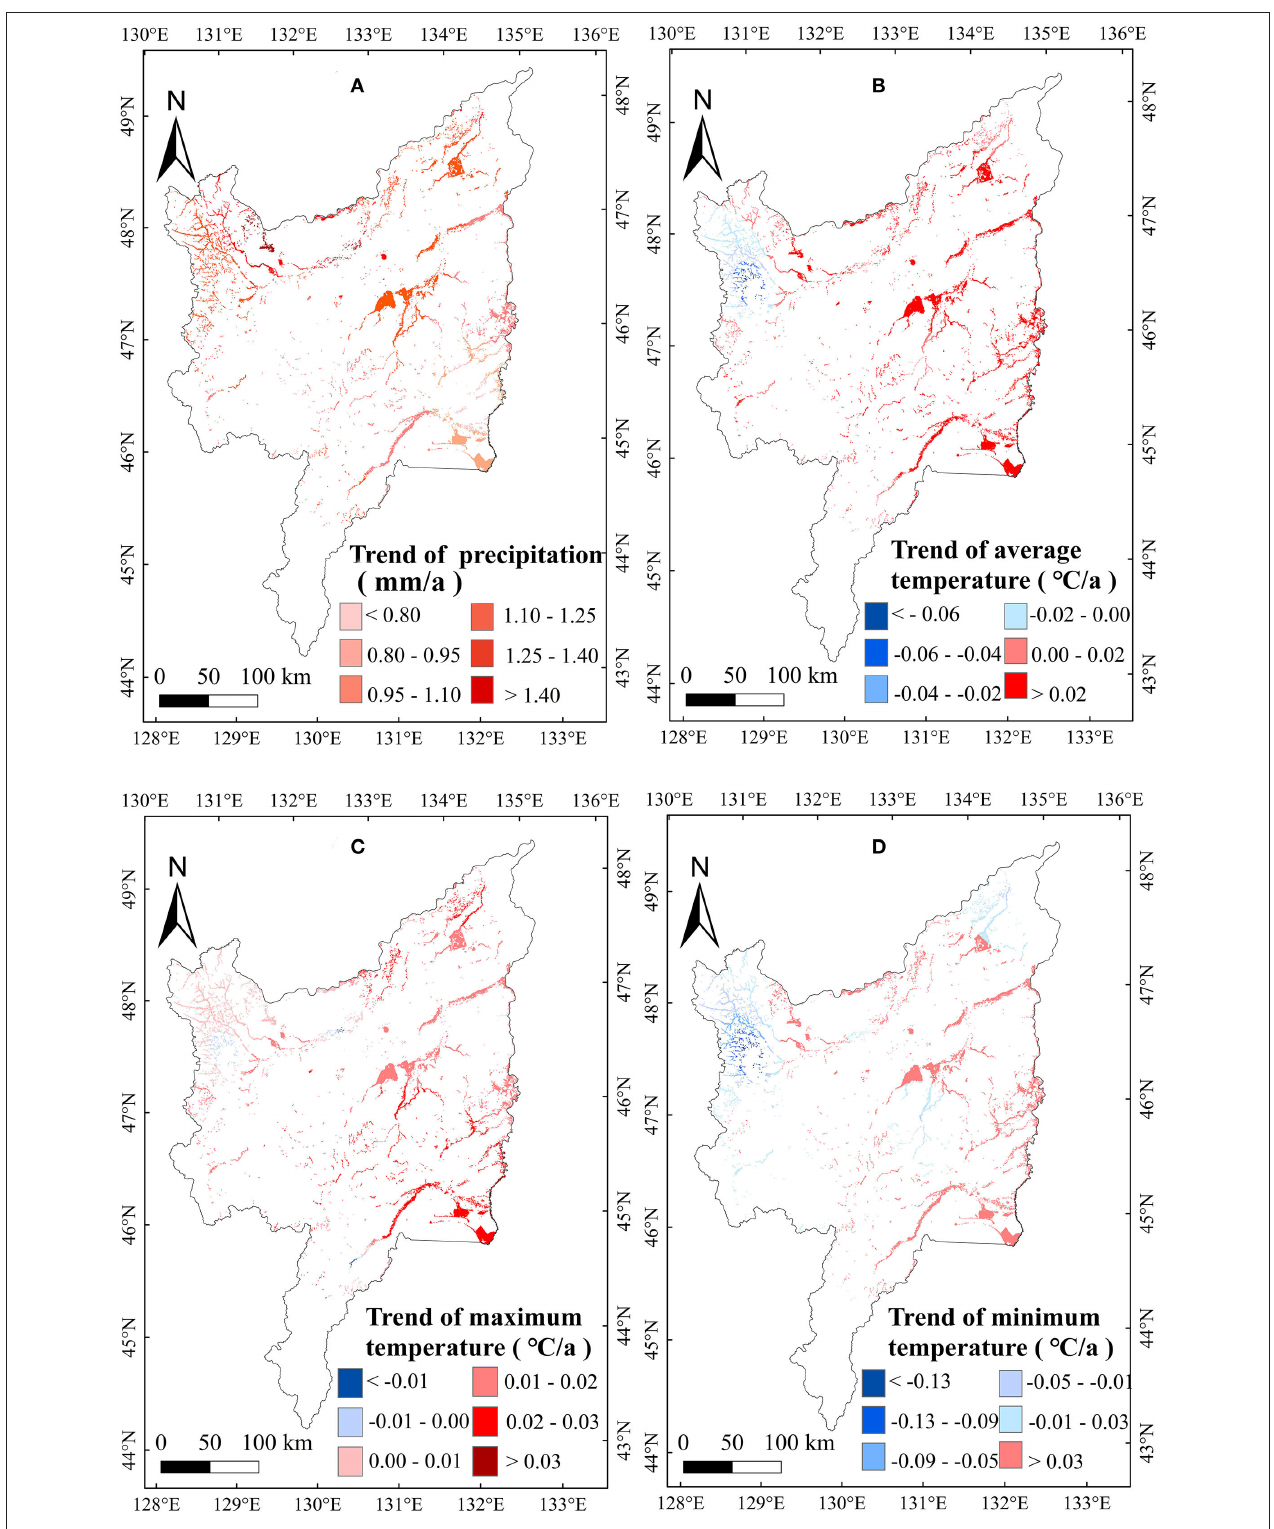
FIGURE 9 | Change trends in annual precipitation (mm/a) (A) , T mean ( ◦ C/a) (B) , T max ( ◦ C/a) (C) , and T min ( ◦ C/a) (D) in marshes of the Sanjiang Plain from 2000 to 2020.